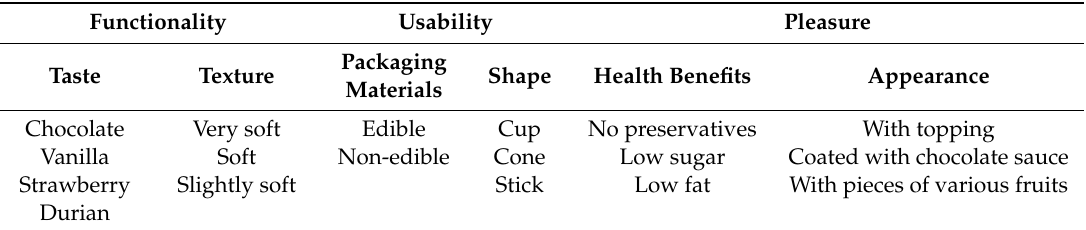
Table 5. Attributes and variants of product configuration.